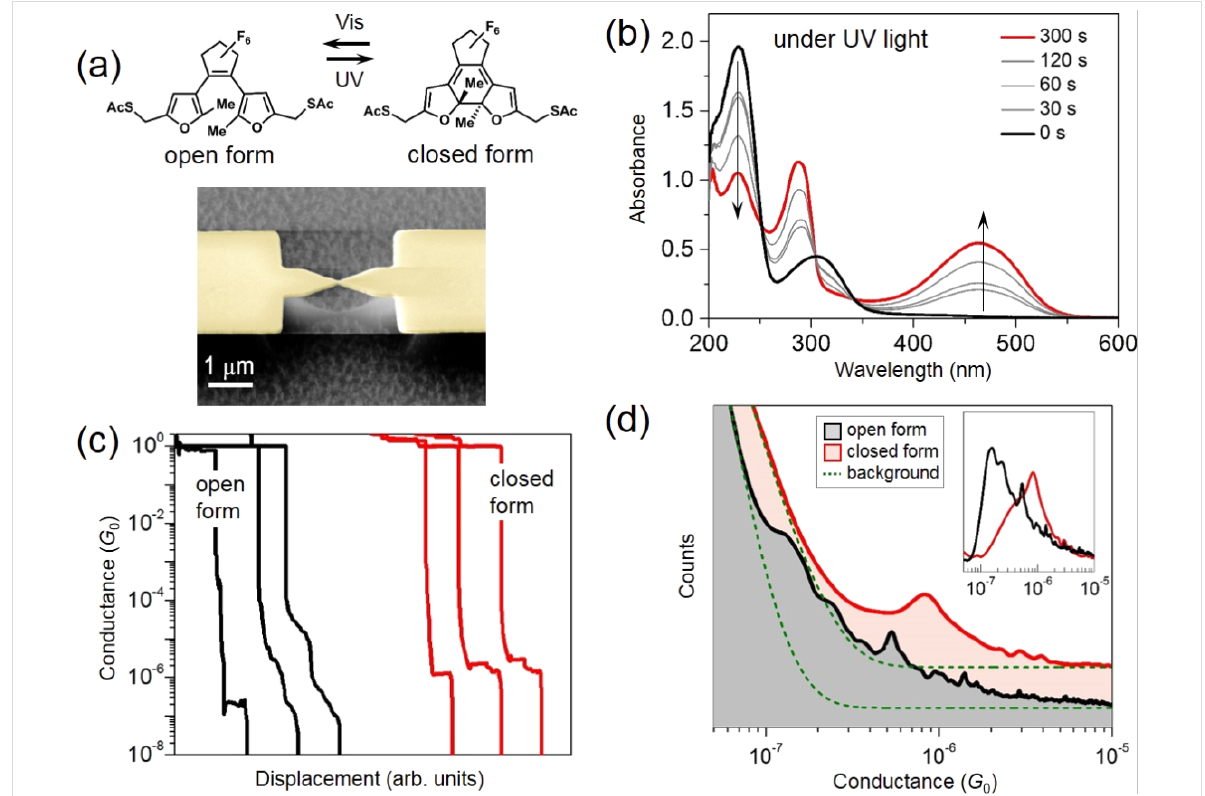
Figure 1: (a) Structures of the open and closed forms of difurylethene-thio-methyl (C5F-ThM) molecules, which switch states under the illumination with UV and visible light. Shown at the bottom is a scanning electron microscopy image of a MCBJ device. (b) Variation of UV–visible absorption spectra under UV light irradiation (wavelength of 313 nm with an intensity of ca. 0.15 mW/cm − 2 ) as a function of illumination time. The black curve cor- responds to the open form, the red one to the closed form. (c) Conductance traces recorded while breaking C5F-ThM molecular junctions, containing the open form (black) and the closed form (red). Curves are shifted along the displacement axis for clarity. (d) Conductance histograms constructed from around 1000 curves of breaking and forming processes. The lowest conductances for the open and closed forms are (1.4 ± 1.0) × 10 − 7 G 0 and (8.3 ± 4.5) × 10 − 7 G 0 , respectively. Histogram curves of both forms (black and red lines) are displaced along the counts axis for better visibility. The inset shows the corresponding conductance histograms after subtracting the exponential backgrounds indicated by green dashed lines in the main